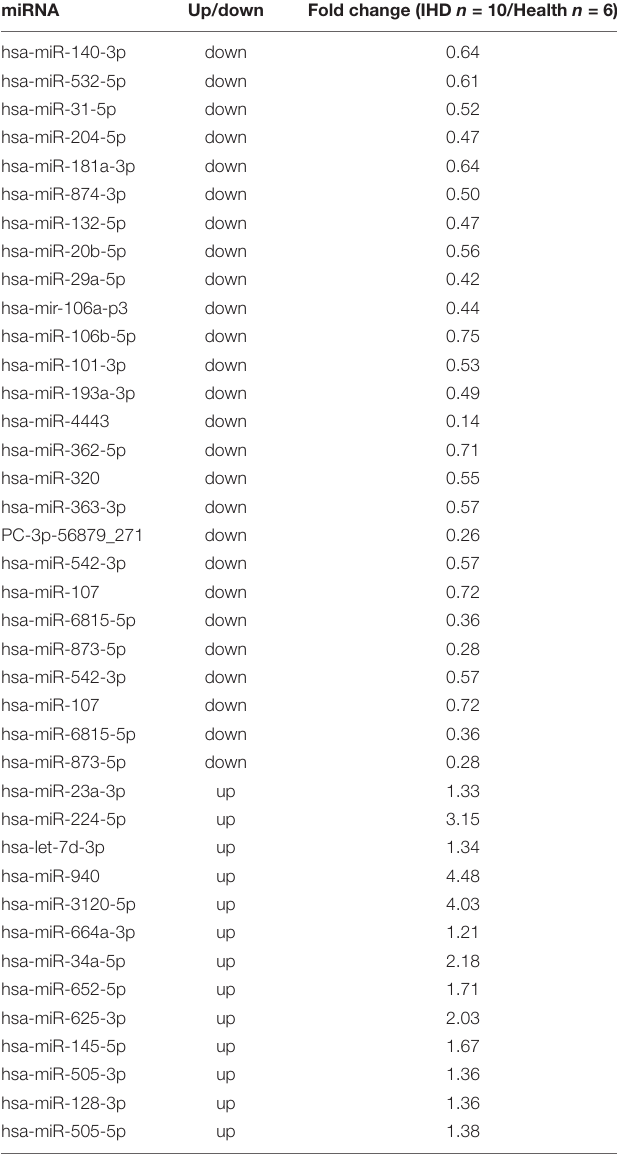
TABLE 2 | List of exosomal microRNA (miRNA) candidates ( p < 0.05) from high-throughput sequencing. miRNA Up/down Fold change (IHD n = 10/Health n = 6)